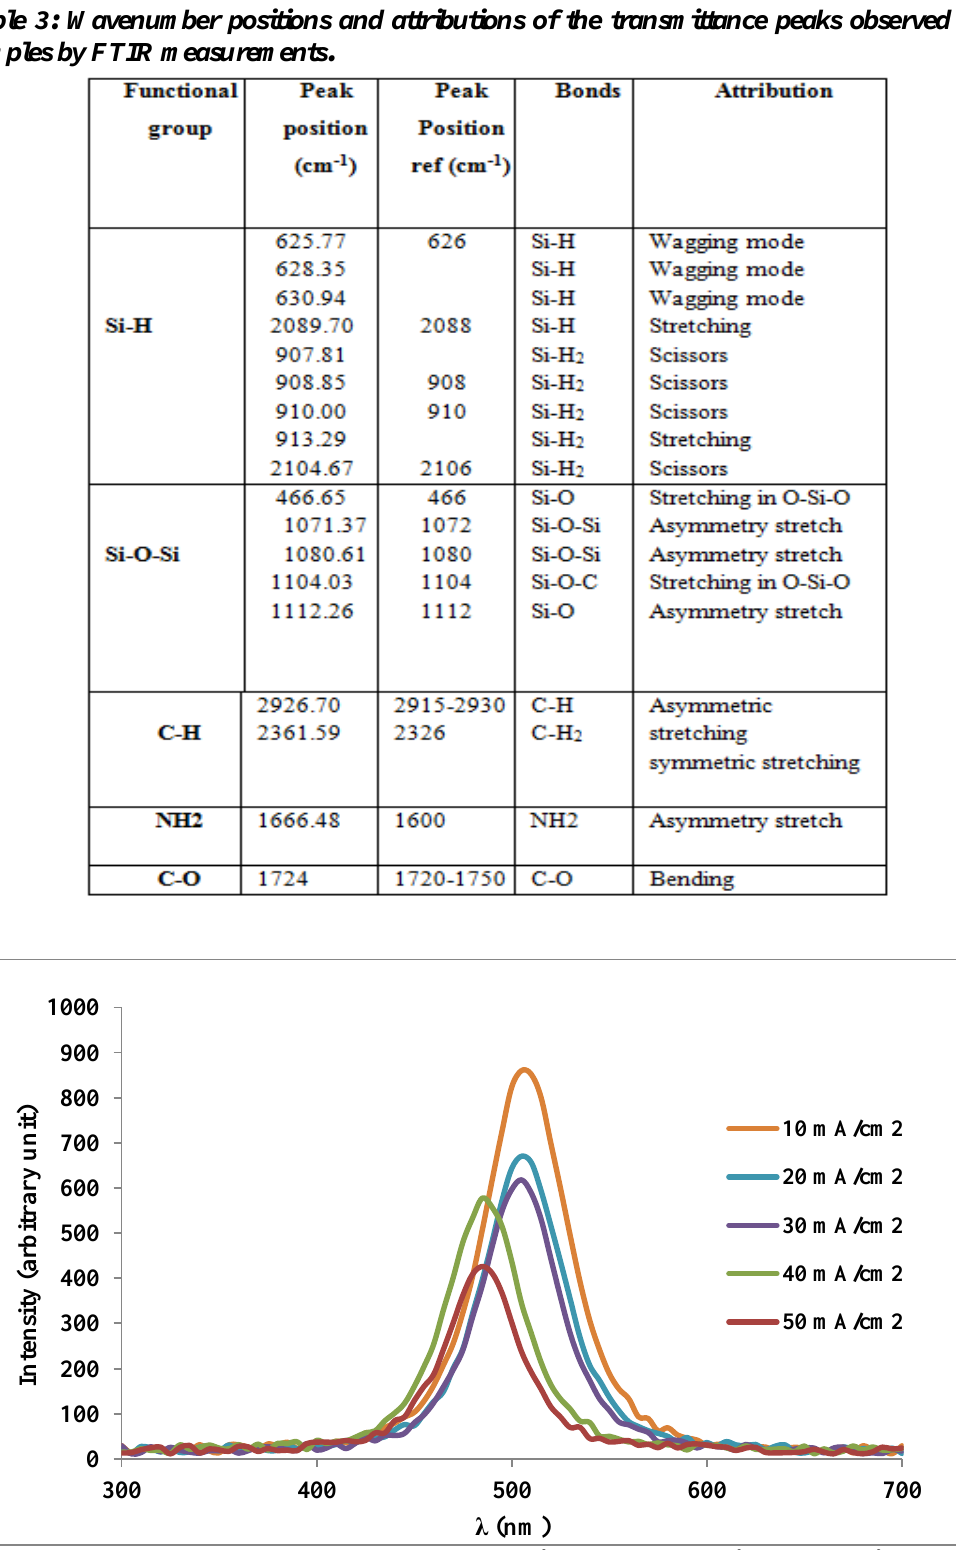
Fig. 7: The photolumenscence spectrum of PS which prepared at different etching current 10, 20, 30, 40,